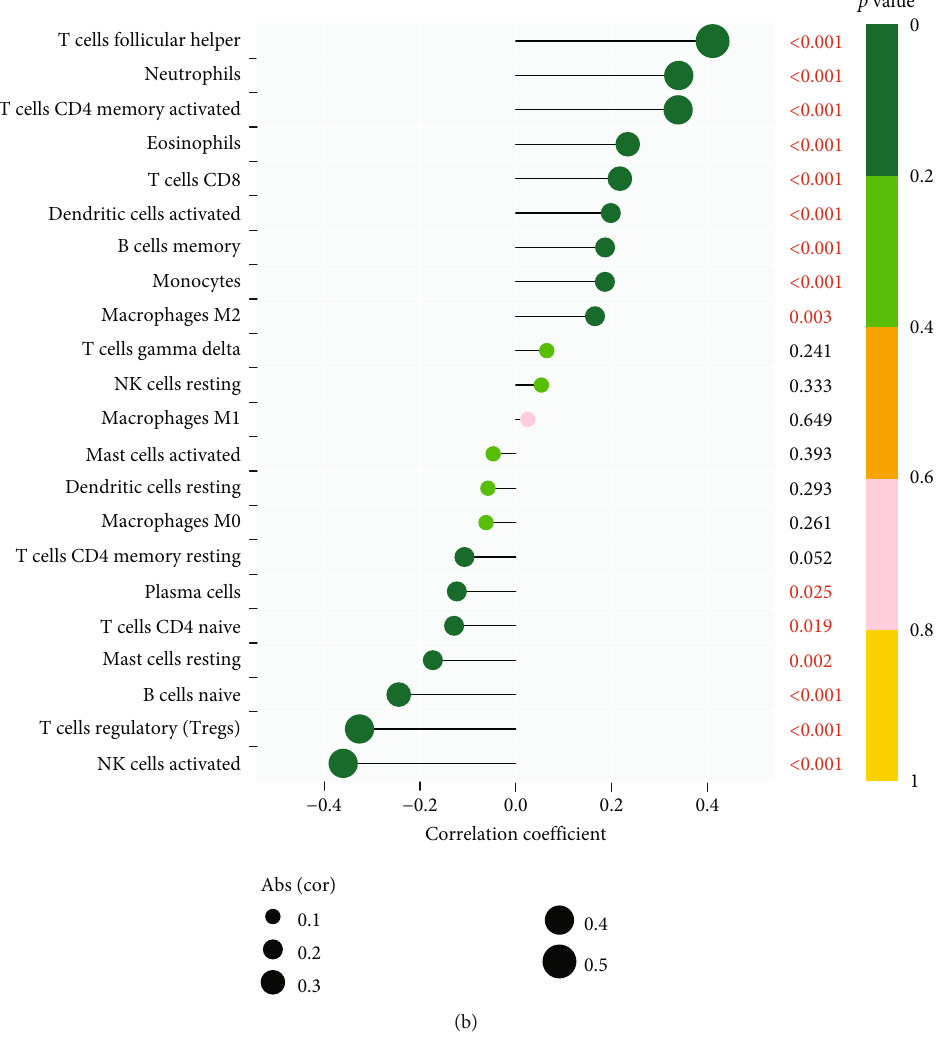
Figure 8: Correlation between (a) ISG20, (b) SERPINA3, and in fi ltrating immune cells in renal fi